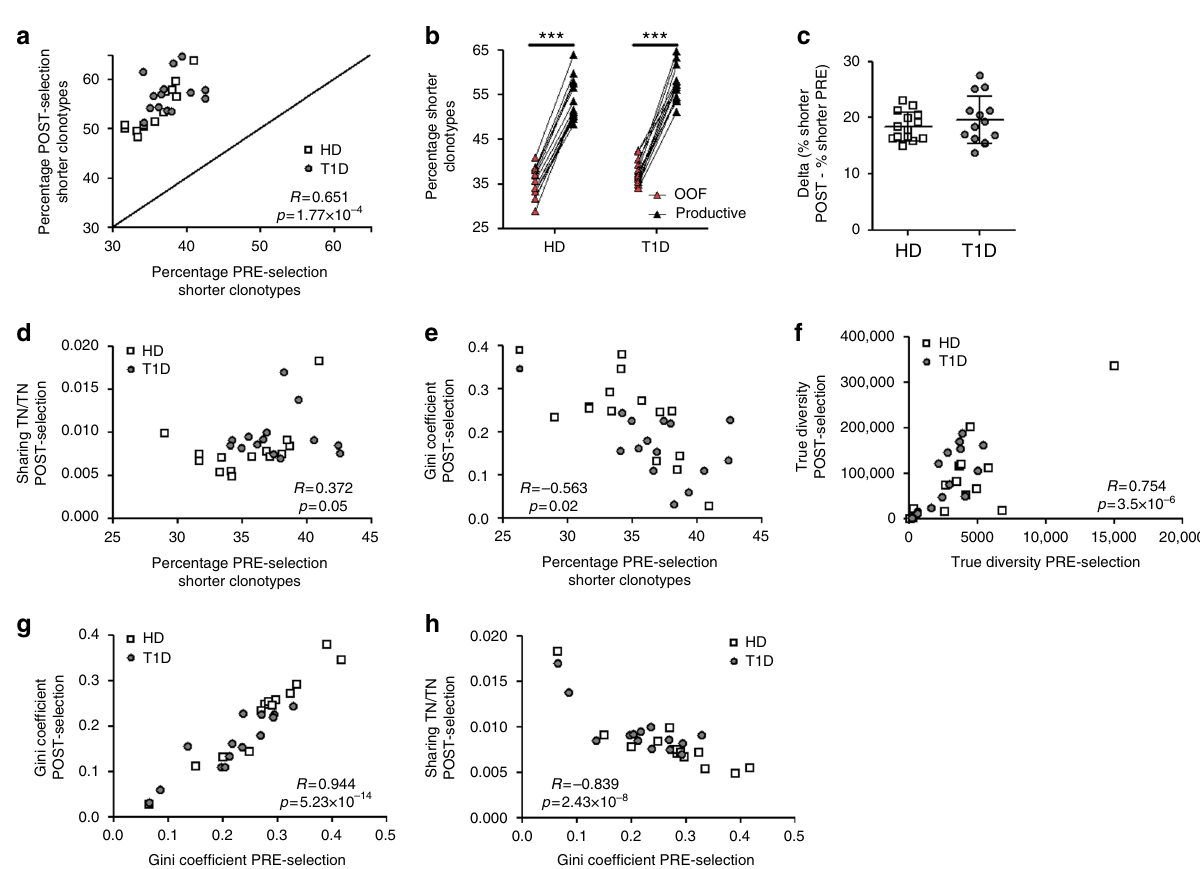
PRE-selection0.4 0.40.5 Gini coefficient Fig. 4 Correlations between diversity, sharing and TCRB CDR3 length pre- and post- selection. a TCRB CDR3 length correlates between pre- and post- selection repertoires. b Short TCRB CDR3s are enriched during thymic selection, both in type 1 diabetes patients (T1D) and healthy donors (HD) (paired t -test. *** p < 0.001). c There are no differences in the degree of enrichment in short TCRB CDR3s in T1D patients versus HD (unpaired t -test. Lines represent the mean ± SD). d , e The percentage of pre-selection shorter clonotypes correlates positively with the post-selection sharing ( d ) and negatively with the post-selection clonality ( e ). f , g Pre- and post-selection diversity indices correlate ( f , true diversity; g , clonality). h Clonality of the pre-selection repertoire correlates with post-selection sharing. a , d – h : Pearson's